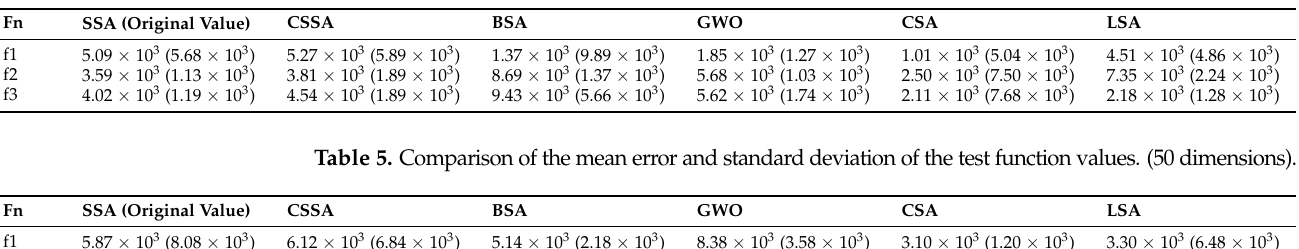
Table 4. Comparison of the mean error and standard deviation of the test function values. (30 dimensions).